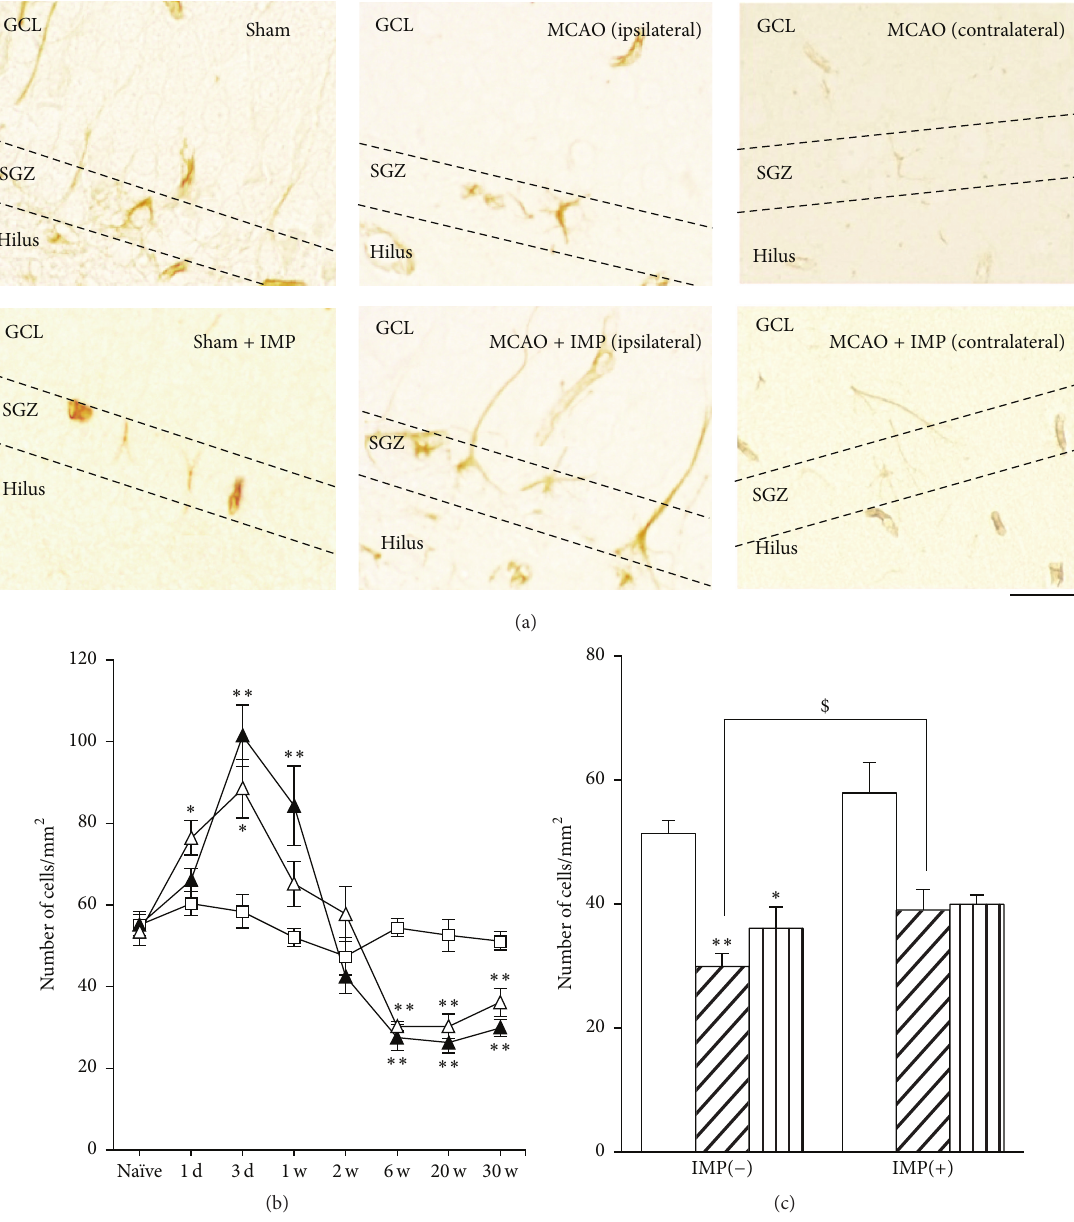
Figure 11: Analysis of Nestin immunopositive cells in GCL. (a) Typical images of the slices taken at 30 weeks after MCAO. Scale bar indicates 20 𝜇 m. (b) Time course changes of Nestin immunopositive cells after MCAO in GCL. Symbols used are as follows: open square, sham; closed triangle, ipsilateral MCAO; open triangle, contralateral MCAO. Statistical significance was evaluated with two-way ANOVA followed by = 53.9 ; 𝐹 = 0.097 ; 𝐹 = 12.5 ; ∗ 𝑃 < 0.05 and ∗∗ 𝑃 < 0.01 versus Tukey-Kramer test at each time point ( 𝐹 ( ( group )2 ( time ∗ group )14,96 time )7